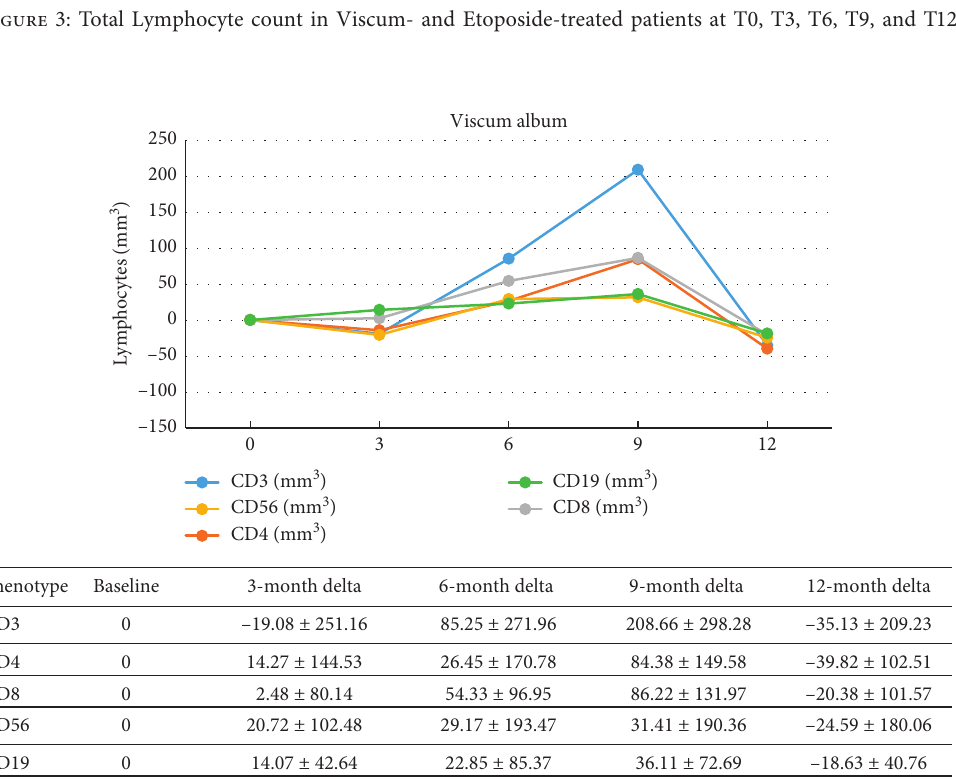
Figure 3: Total Lymphocyte count in Viscum- and Etoposide-treated patients at T0, T3, T6, T9, and T12.